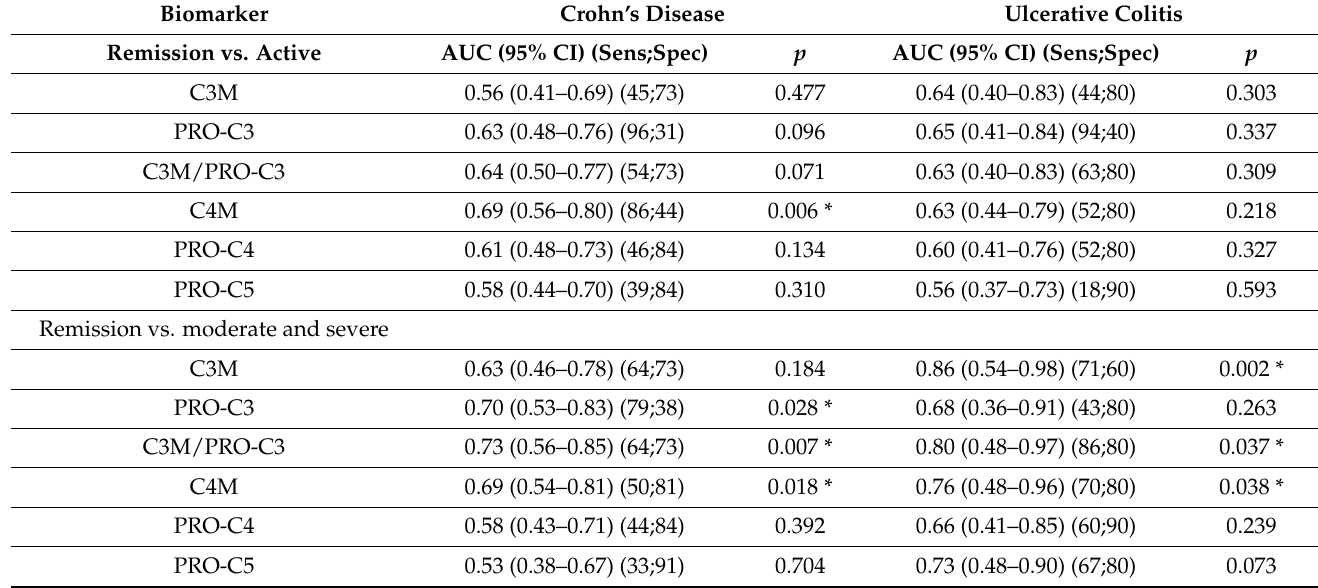
Table 3. Diagnostic power of single collagen biomarkers to discriminate between inflammatory bowel disease patients in endoscopic remission and active disease.